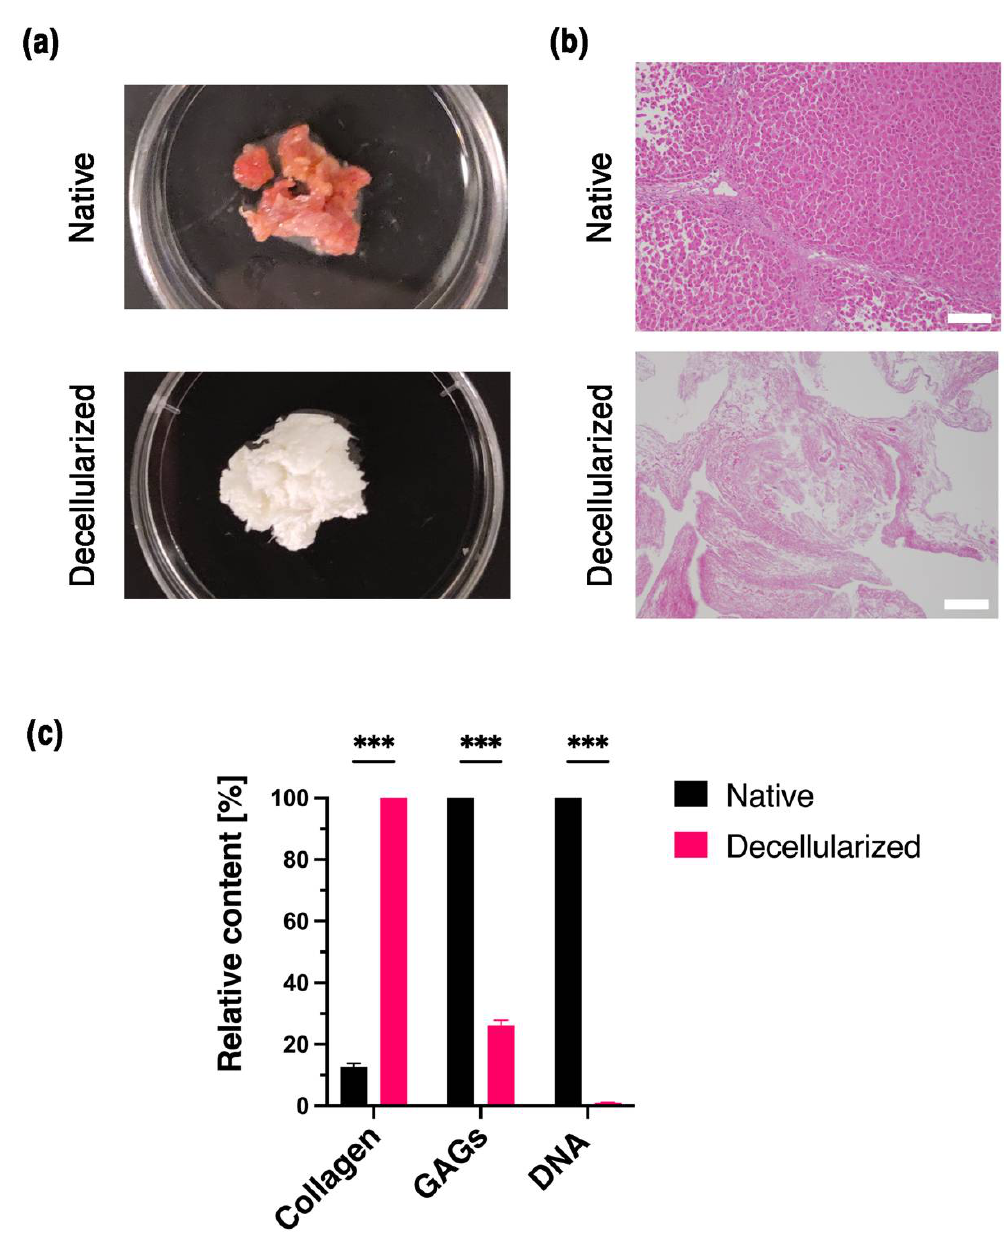
Figure 2. Decellularization and the biochemical analysis of liver tissue. ( a ) Optical image of native and decellularized liver tissue and ( b ) microscopic image of native and decellularized liver tissue (scale bar 100 µ m). ( c ) Liver ECM components collagen and GAGs with the DNA content of native and decellularized tissue. All experiments were conducted in triplicate. Error bars display the standard error of the mean (*** p <